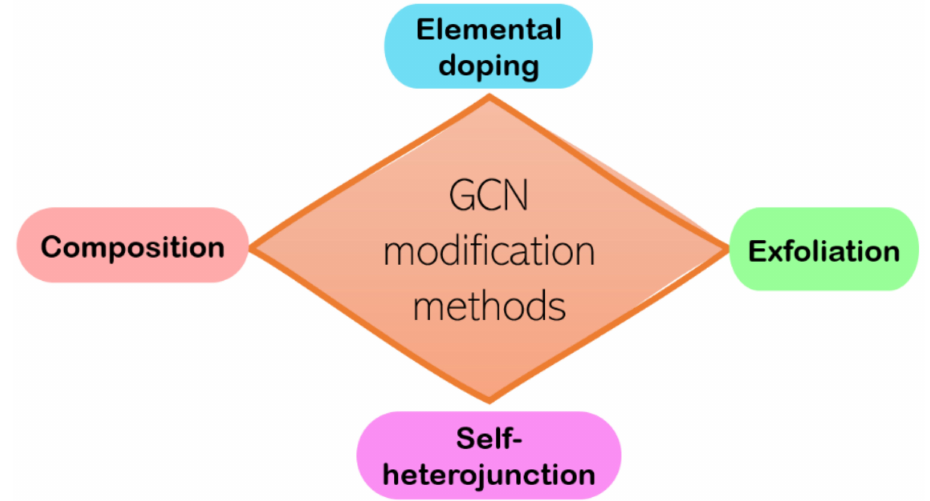
Figure 5. A summary of the GCN modification